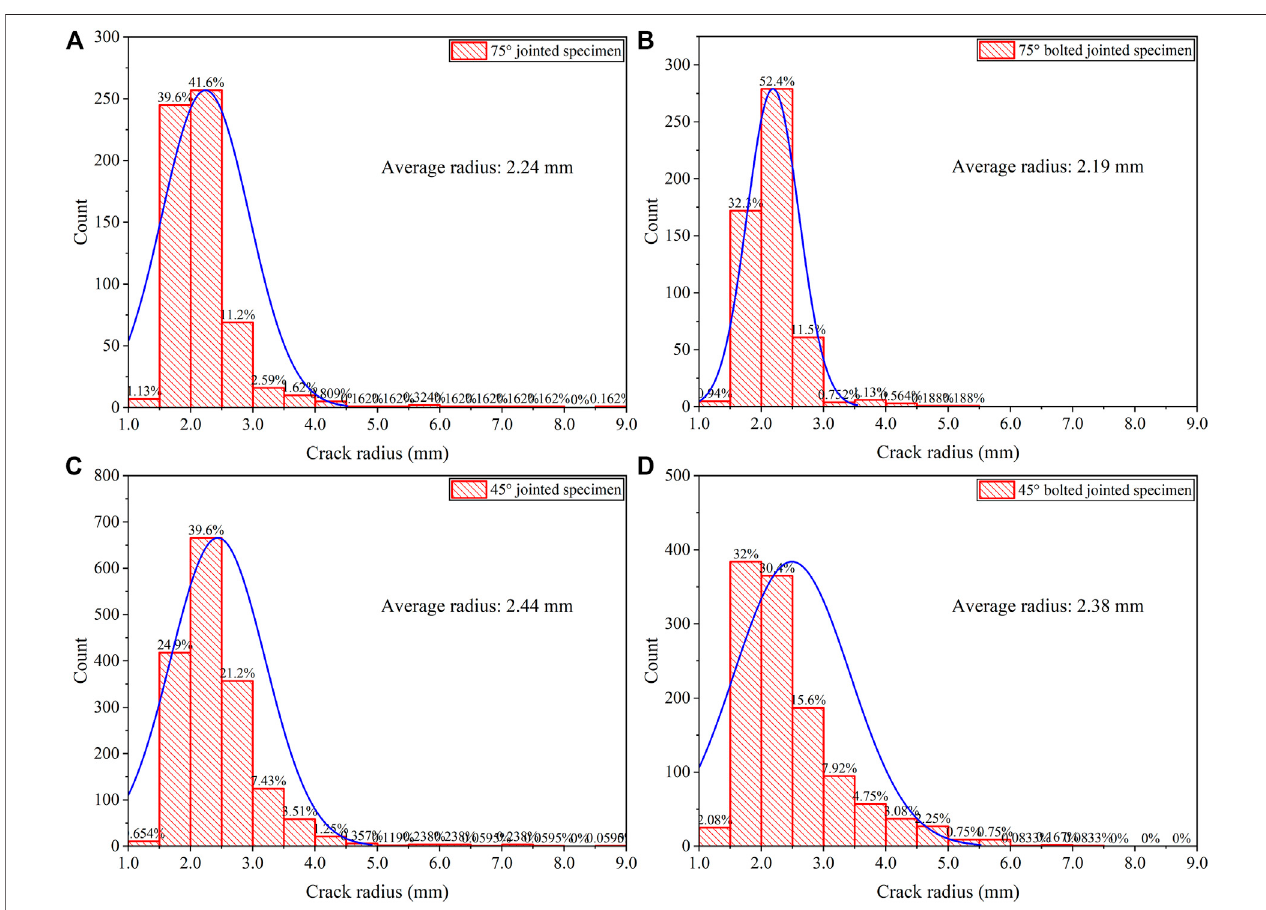
FIGURE 5 | Crack radius distribution of jointed and bolted jointed specimens under uniaxial compression: (A) 75 ° jointed specimen, (B) 75 ° bolted jointed specimen, (C) 45 ° jointed specimen, and (D) 45 ° bolted jointed specimen.